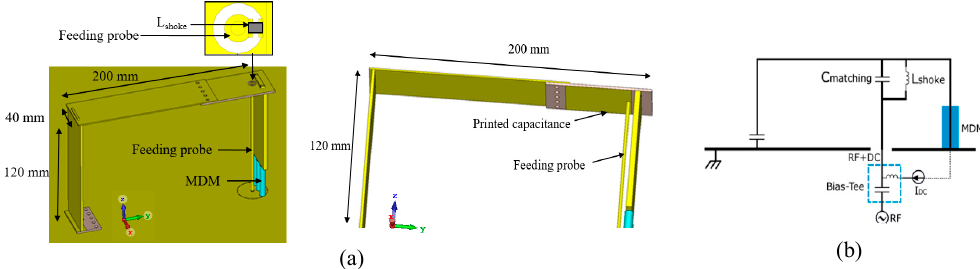
Figure 1. ( a ) Antenna design and ( b ) schematic view of the antenna with the biasing